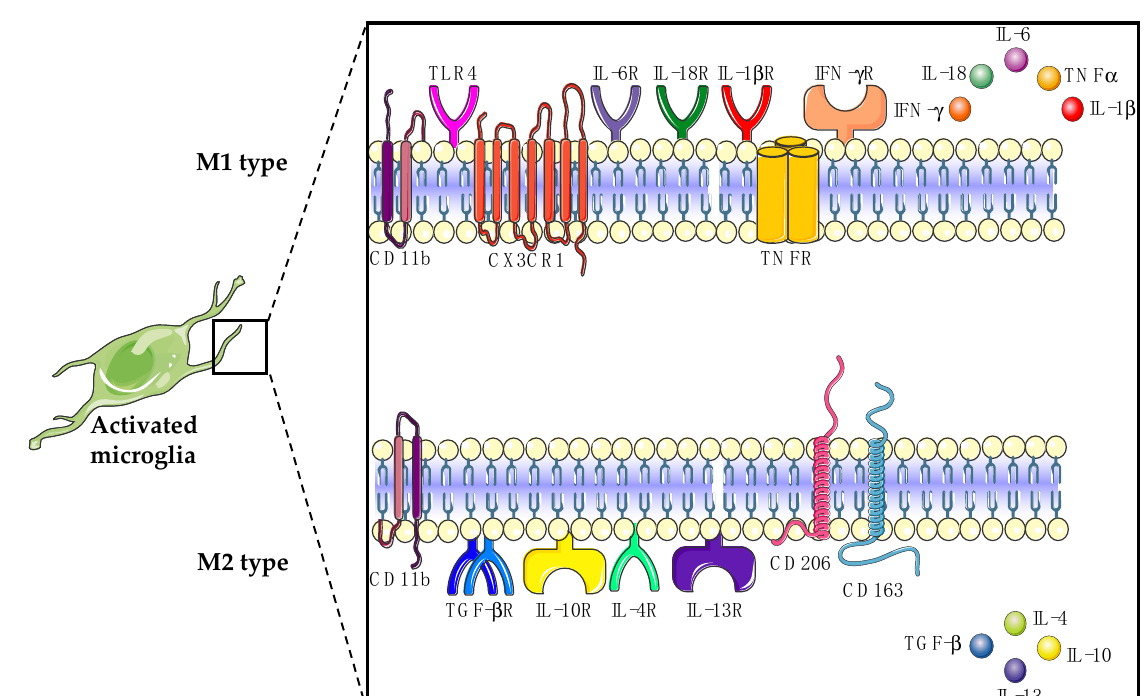
Figure 1. Classically activated M1-type microglia release proinflammatory cytokines, whereas alternatively activated M2-type microglia release anti-inflammatory cytokines. CD: cluster of differentiation; CX3CR1: C-X3-C motif chemokine receptor 1; TNF α : tumor necrosis factor alpha; TNFR: TNF α receptor; IFN- γ : interferon gamma; IFN- γ R: IFN- γ receptor; TLR4: toll-like receptor 4; IL: interleukin; TGF β : transforming growth factor beta; TGF β R: TGF β receptor.